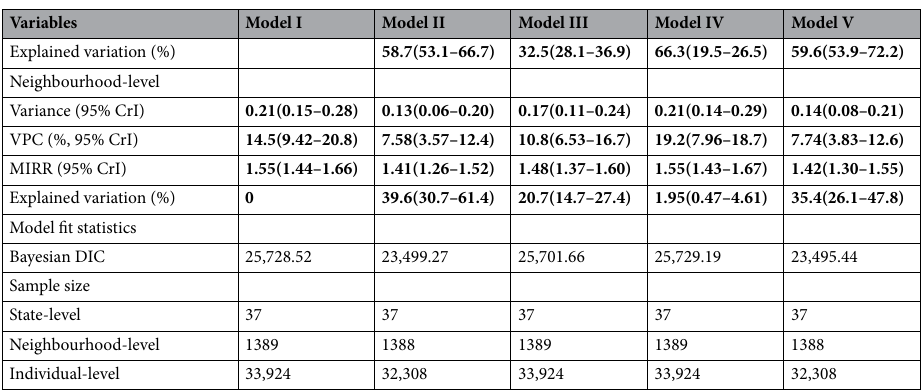
Table 4. Individual compositional and contextual factors associated with under-five mortality identified by multivariable Bayesian multilevel Poisson regression models. IRR Incidence Rate Ratio; CrI–credible interval,